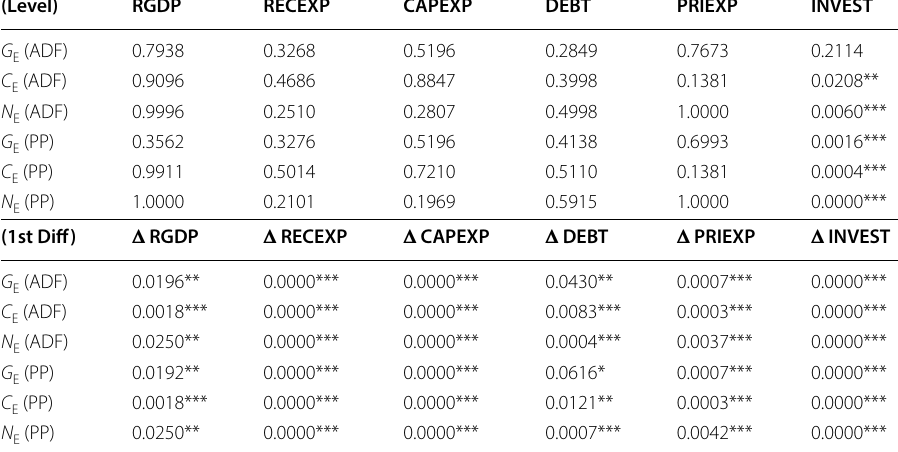
Table 1 Unit root